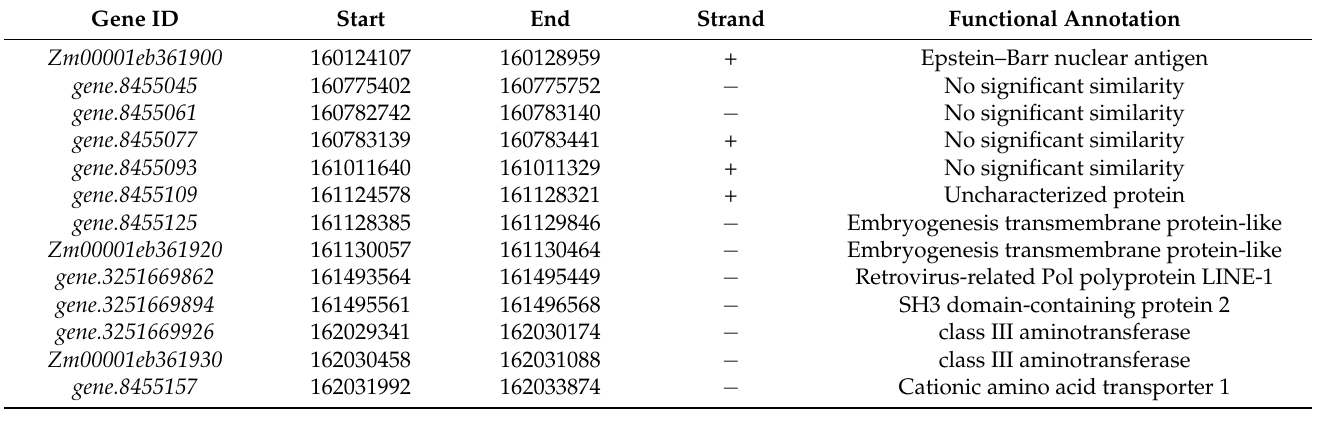
Table 3. Predicated genes in the ZmGHT1 locus, their chromosomal location, and functional annotations.